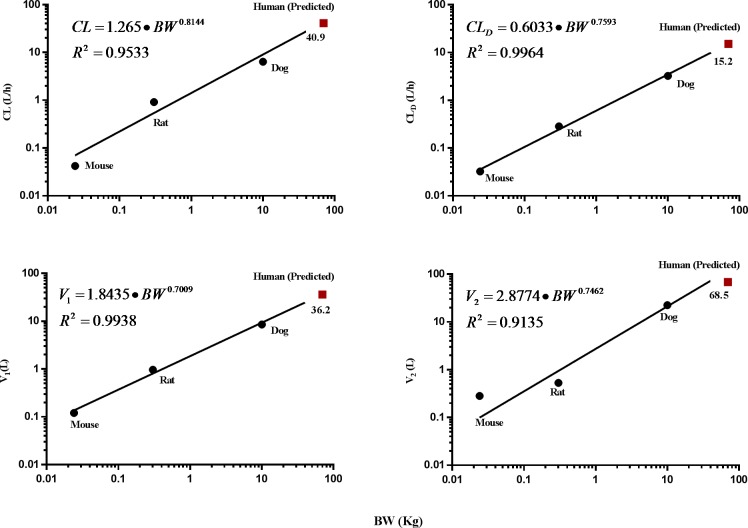
Log-log representation of the allometric relationship in various pharmacokinetic parameters: clearance (A), distribution clearance (B), and central (C) and peripheral (D) volume of distribution.